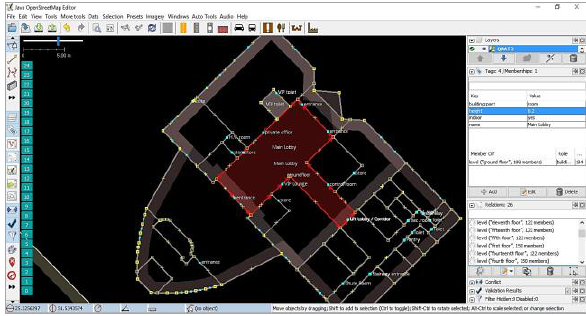
Figure 7. Key value pairs added for building interior spaces